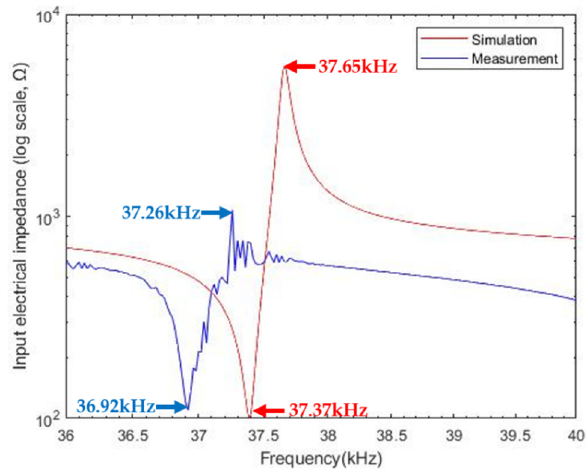
Figure 8. Magnitude of input impedance: simulation and measurement.